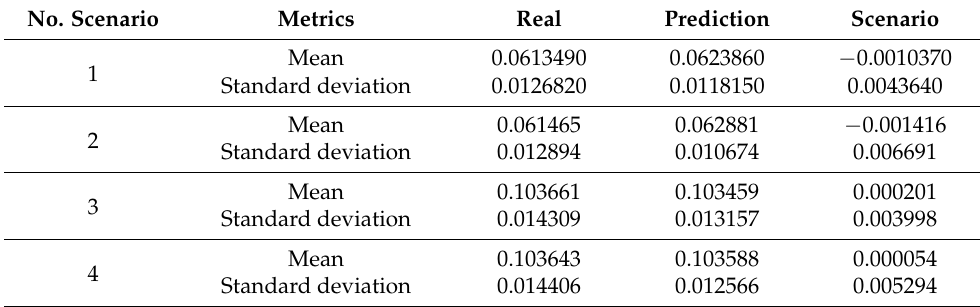
Table 6. Model quality metrics.